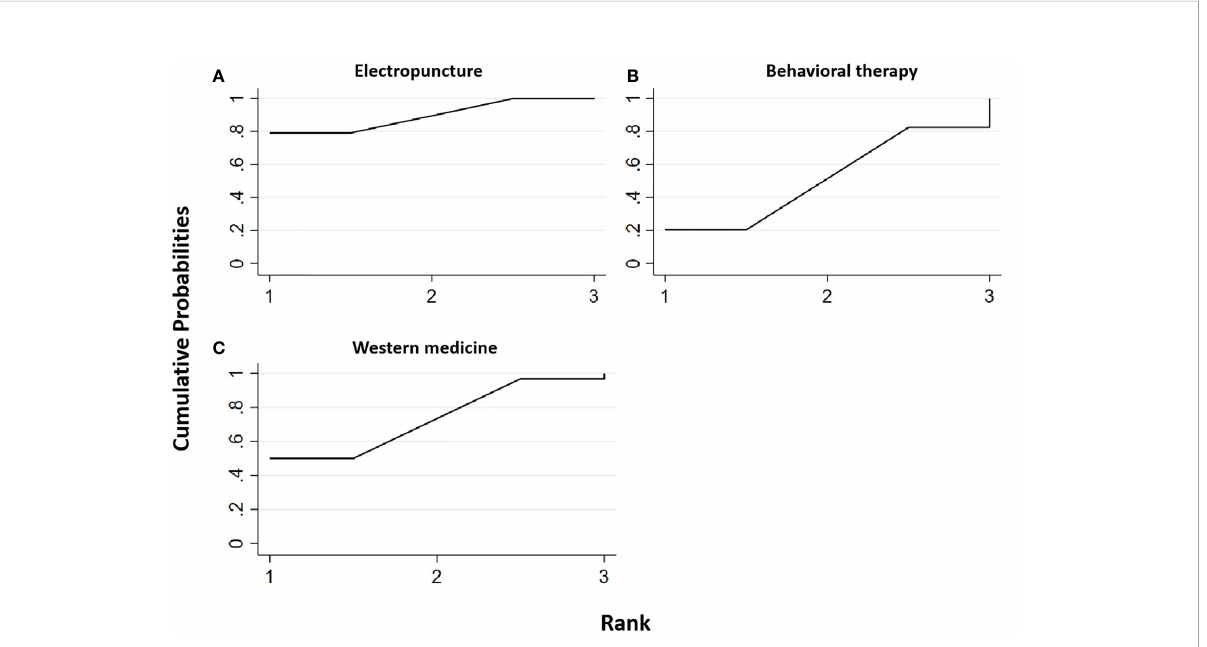
FIGURE 11 Ef fi cacy ranking and cumulative probability graph of high-density lipoprotein (HDL) treated by different types of intervention. Comparison of ef fi cacy ranking and cumulative probability of HDL between each kind of intervention. (A) Electropuncture, (B) behavioral therapy, and (C) western